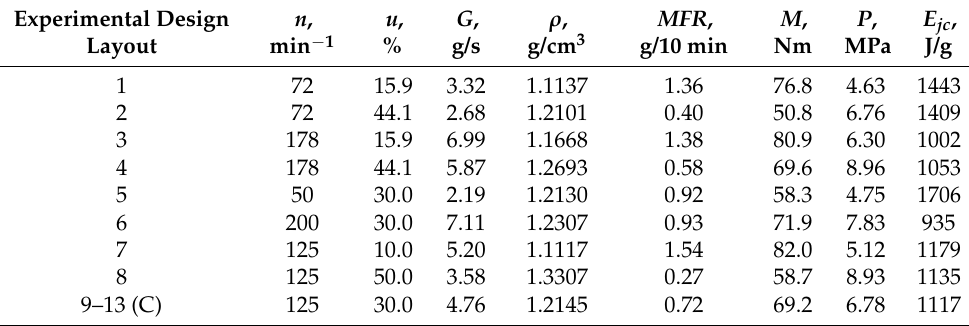
Table 1. Experimental design and experimental test results – mean